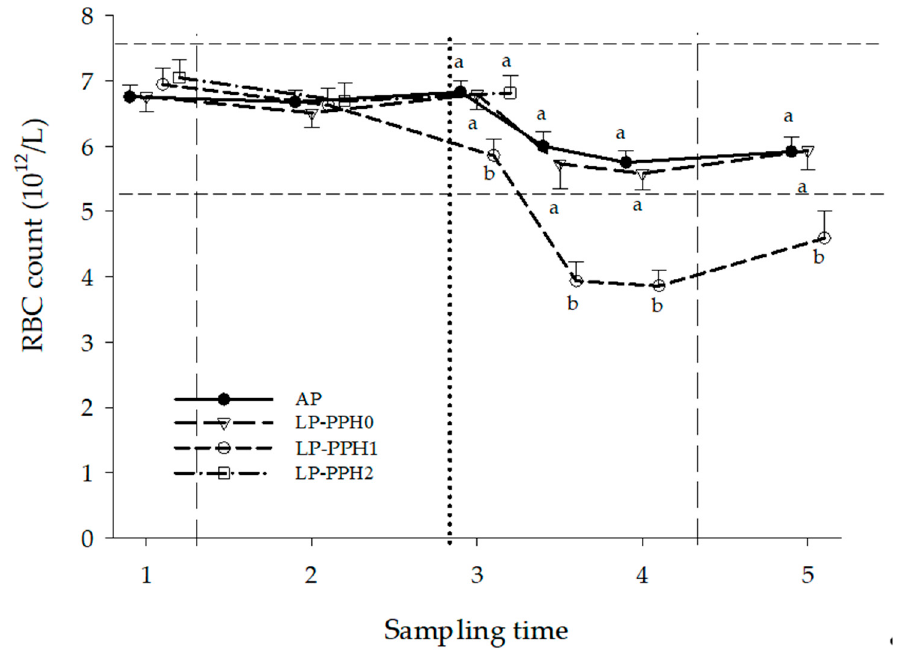
Figure 4. Red blood cell (RBC) counts of dairy cattle receiving a diet with adequate P content (AP, n = 18) or a P deficient diet (LP, n = 18) in the periparturient period. LP-PPH2: cows that developed clinical PPH (i.e., hemoglobinuria; n = 5), LP-PPH1: cows with subclinical PPH (n = 6); LP-PPH0: cows without evidence for PPH (n = 7). The vertical dashed lines mark the beginning and end of the phosphate depletion and repletion phase of the study. The vertical dotted line indicates calving. The horizontal dashed lines present the upper and lower limit of the reference range for RBC in cattle. Values of groups with different lower case letterss differ from each other at that specific sampling time. Table 2. Packed cell volume (%) of periparturient dairy cattle receiving AP or LP diet. Sampling Time p Value